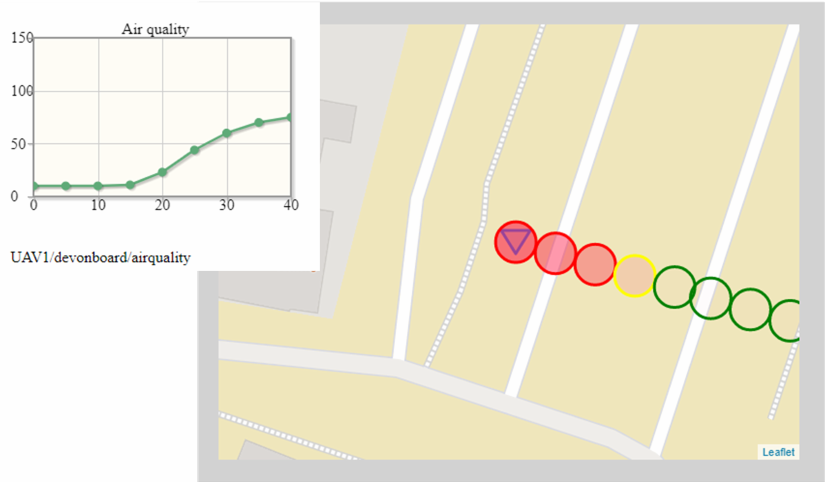
Figure 5. Exemplary situational context (current exhaust gas concentration associated with spatiotem- poral metadata and short-term historical data): bad air